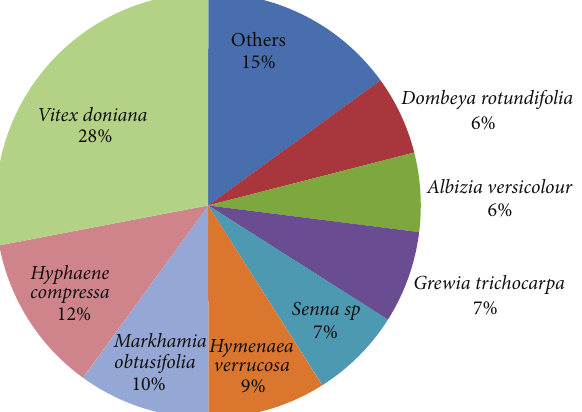
Figure 4: Percentage distribution of regenerants in open forest